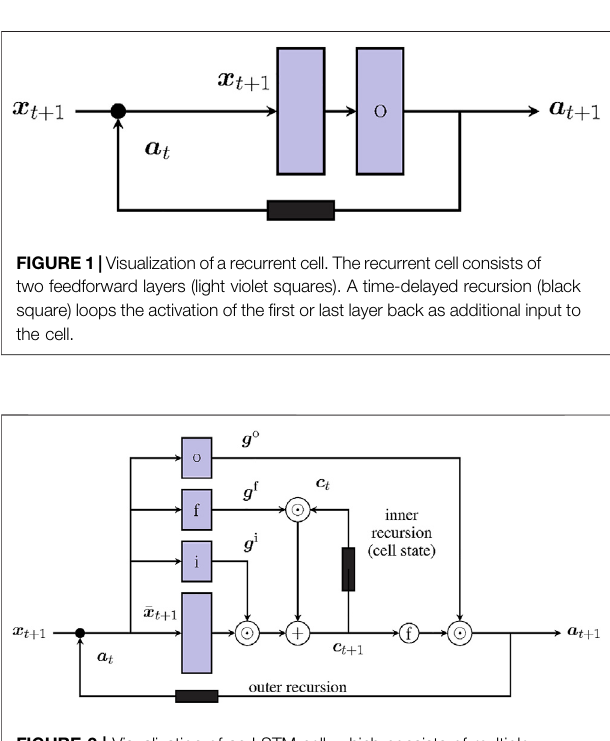
FIGURE 2 | Visualization of an LSTM cell, which consists of multiple feedforward layers (light violet). Three gates, g i , g f , and g o , control the data fl ow into the cell, within the cell, and out of the cell. Two recursions (black rectangles) ensure stable gradients across many time steps.